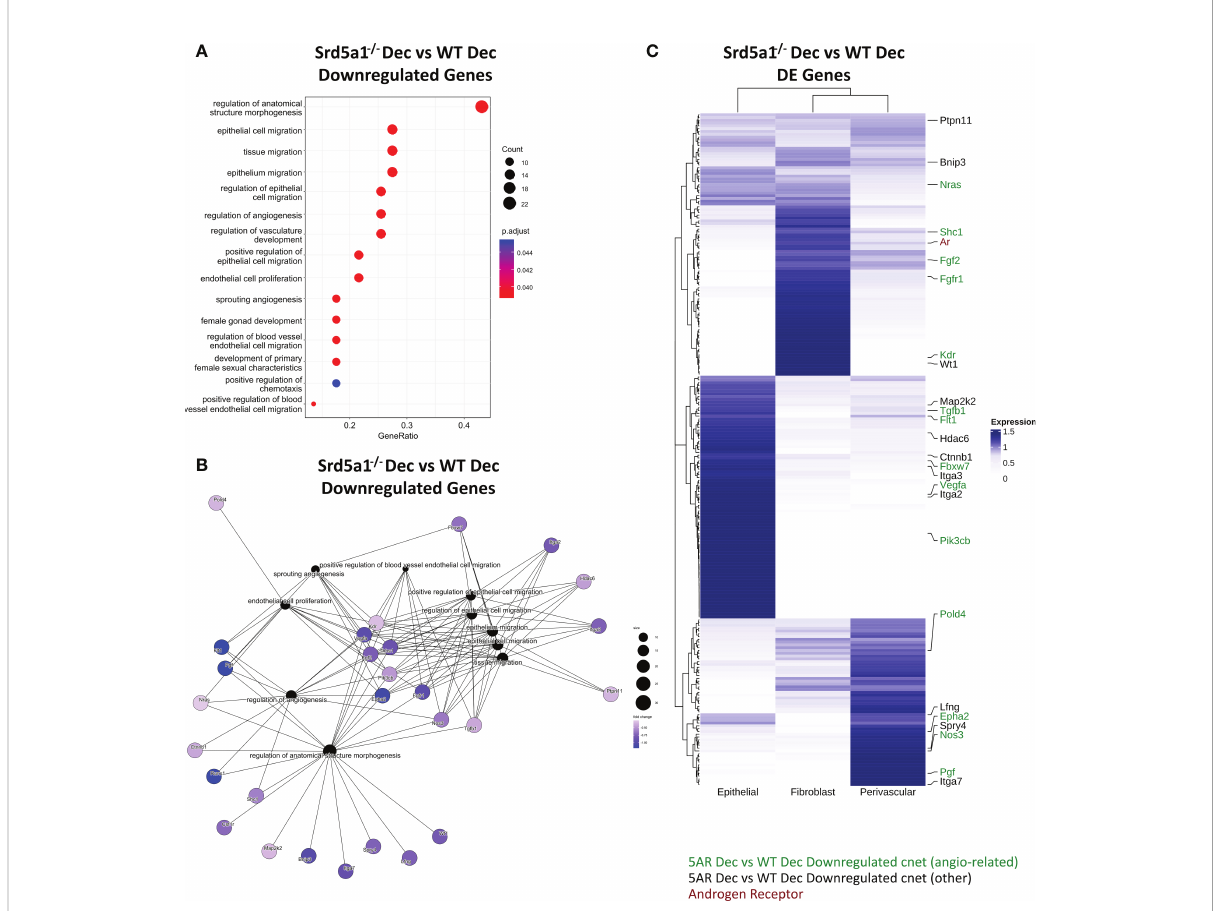
FIGURE 4 Gene networks associated with defective decidualization in Srd5a1 -/- mice. (A) Biological process gene ontogeny (GO) of genes signi fi cantly downregulated in Srd5a1 -/- vs. WT decidualized uterine horns. All signi fi cant terms shown. (B) Category netplot (cnet) embedding indicating genes shared between GO terms for genes signi fi cantly downregulated in Srd5a1 -/- vs. WT decidualized uterine horns. (C) Heatmap showing expression of top DE genes from the Srd5a1 -/- compared to WT decidualized uterine horns and their relative abundance in uterine cell subsets; epithelial, fi broblast and perivascular, as derived from annotation in previously published scRNAseq dataset of mouse uteri. Genes appearing in the cnet plot in B are labelled and color coded based on whether they link to angiogenesis-related GO terms (green) or not